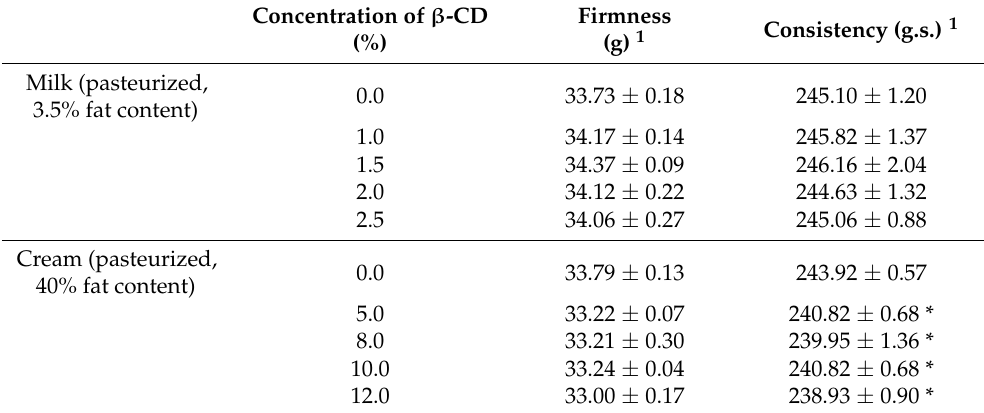
Table 3. The effect of the concentration of β -CD on the textural characteristics of milk and cream.